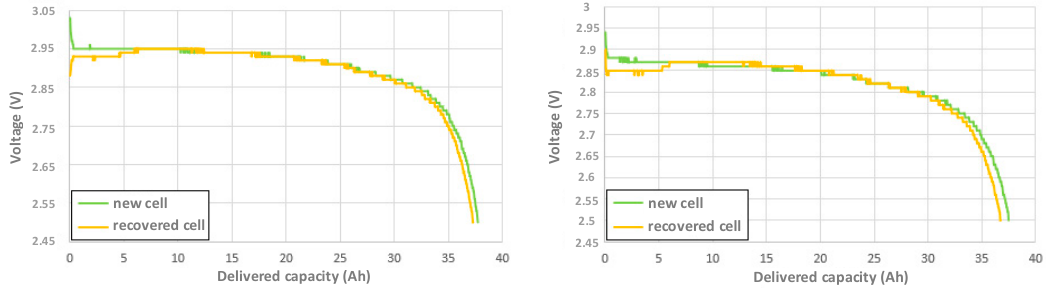
Figure 15. Voltage profile during discharge by 40 A ( left ) and 80 A ( right ) for regenerated (yellow) and referenced cell (green).